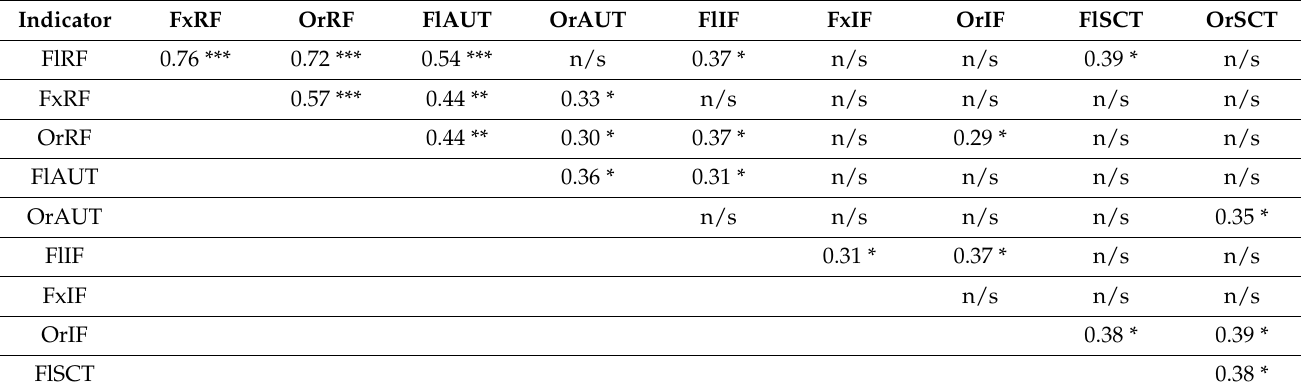
Table 3. The correlation coefficients for the creativity indicators for the